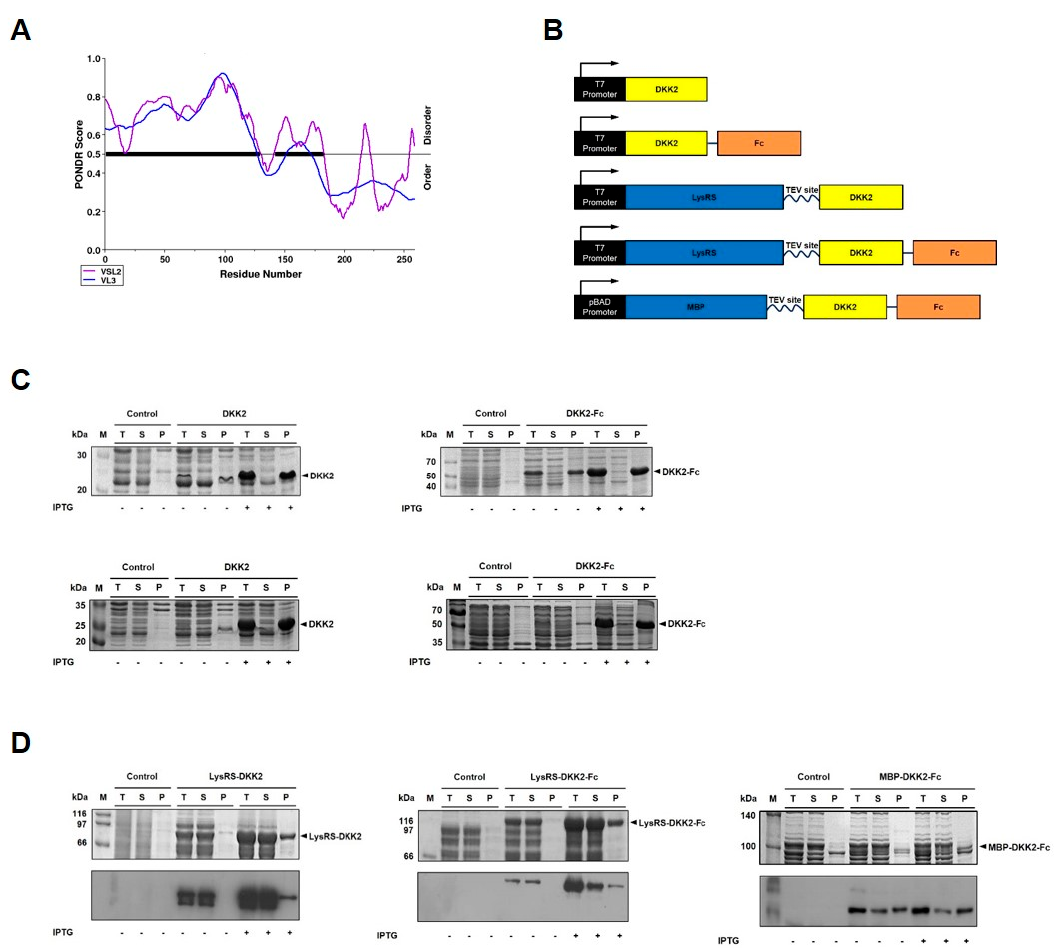
Figure 1. Expression of recombinant DKK2 protein in E. coli . ( A ) Disorder analysis of DKK2. Intrinsic disorder scores of DKK2 were predicted using PONDR ® software. The residues with scores above 0.5 were considered disordered. The thick black line comprising positions 1–129 and 142–182 highlights the disordered locations. ( B ) Schematic diagrams of expression constructs of DKK2, DKK2-Fc, LysRS-DKK2, LysRS-DKK2-Fc, and MBP-DKK2-Fc, respectively. ( C ) Expression of DKK2 or DKK2-Fc in E. coli . Proteins were expressed at 30 ◦ C (upper panels) and 16 ◦ C (lower panels). The solubility of proteins was analyzed by SDS-PAGE. T, S, and P indicate total lysate, soluble fraction, and pellet fraction after centrifugation, respectively. ( D ) Expression of DKK2 and DKK2-Fc with fusion to LysRS and DKK2-Fc with fusion to MBP in E. coli . The solubility of fusion proteins was analyzed by SDS-PAGE (upper panels) and western blotting (lower